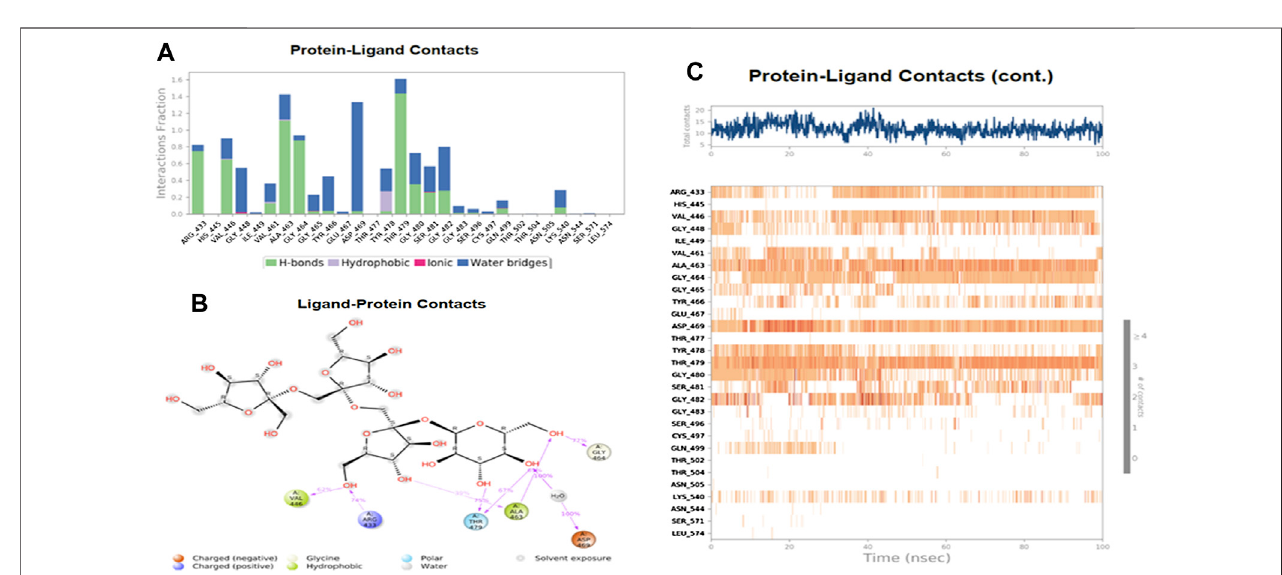
FIGURE7| TheinteractionanalysisofnytosewithUHRF1. (A) UHRF1interactionswithNystosethroughoutthesimulation. (B) Theschematicdiagramshowedthe detailed atomic interaction of Nystose with UHRF1. (C) A timeline representation of UHRF1- Nystose interactions is presented in (A) .